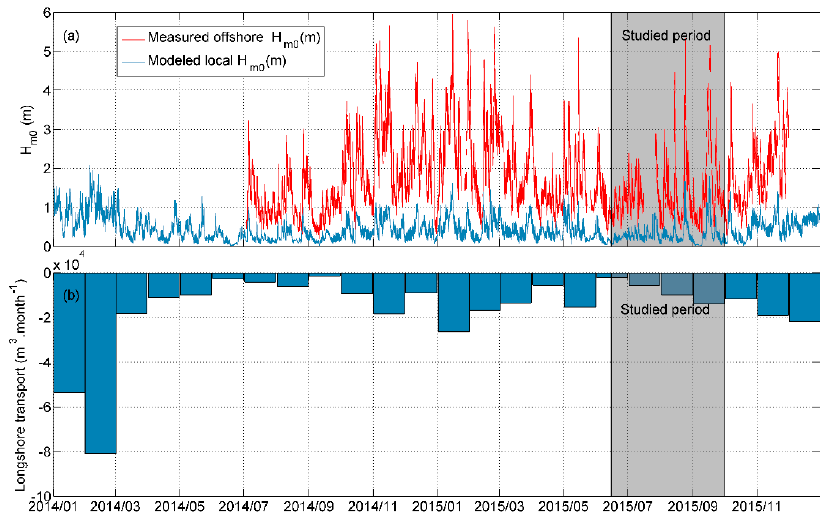
Figure 14. ( a ) Significant wave height measured offshore of Oléron Island (red) and simulated in front of the inlet (blue) between July 2014 and December 2015; ( b ) Longshore transport estimated with wave parameters at breaking extracted from the wave hindcast.